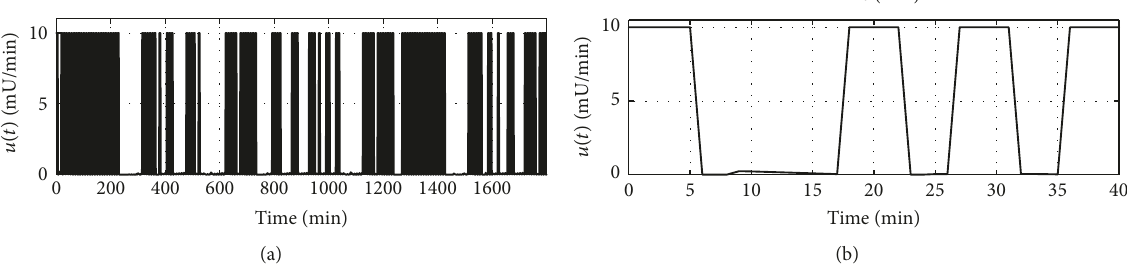
Figure 2: Calculated control signals. (a) represents the whole time horizon. (b) shows a piece of the whole time horizon between 0 and 40 minutes.